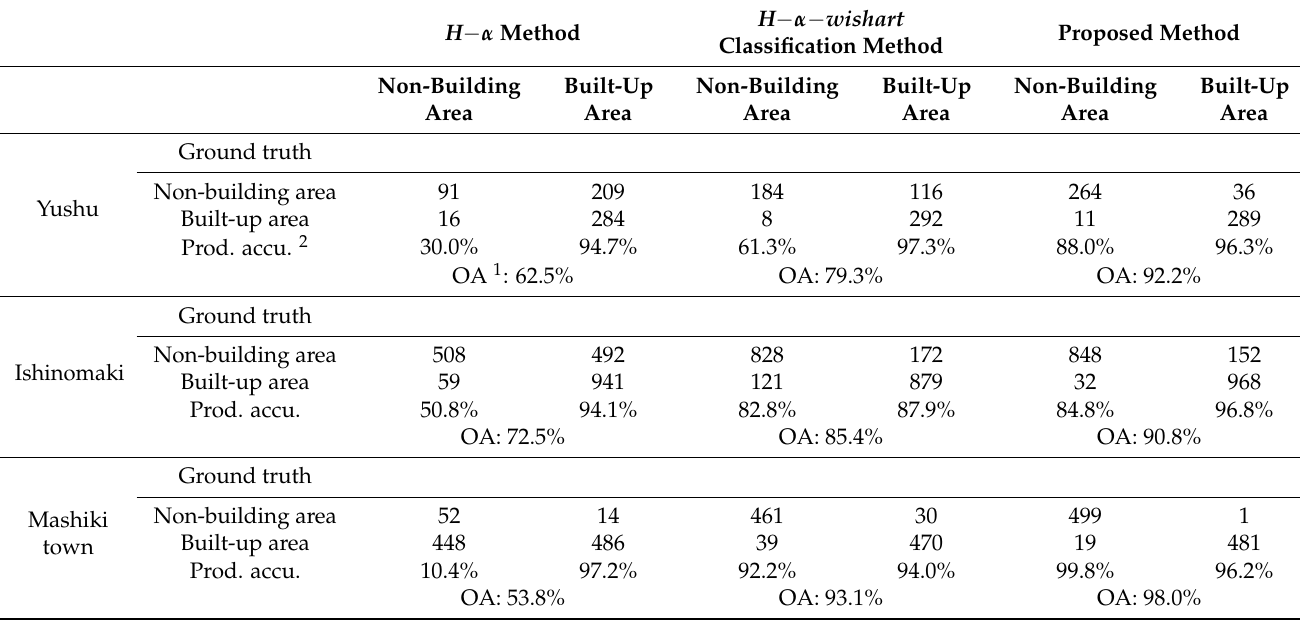
Table 4. Confusion matrix of built-up and non-building area classification in the three study sites with different methods. H − α − H − α Method